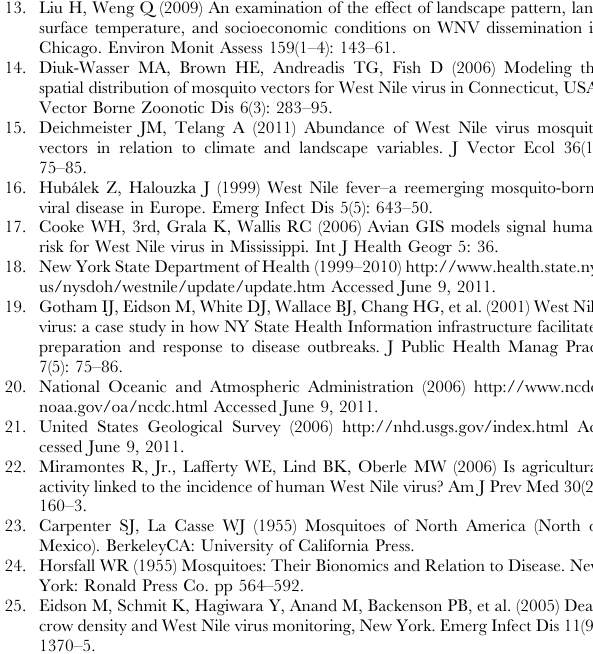
Figure 1. Map of the cumulative West Nile virus cases versus that which is predicted by climate and hydrogeography from the years 2000 to 2010. The number of human WNV cases as graduated symbols are superimposed over the monochrome choropleth of cases predicted by temperature, precipitation and hydrogeographic area.